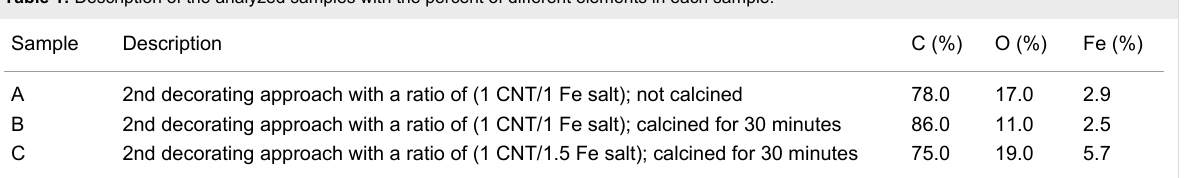
Table 1: Description of the analyzed samples with the percent of different elements in each